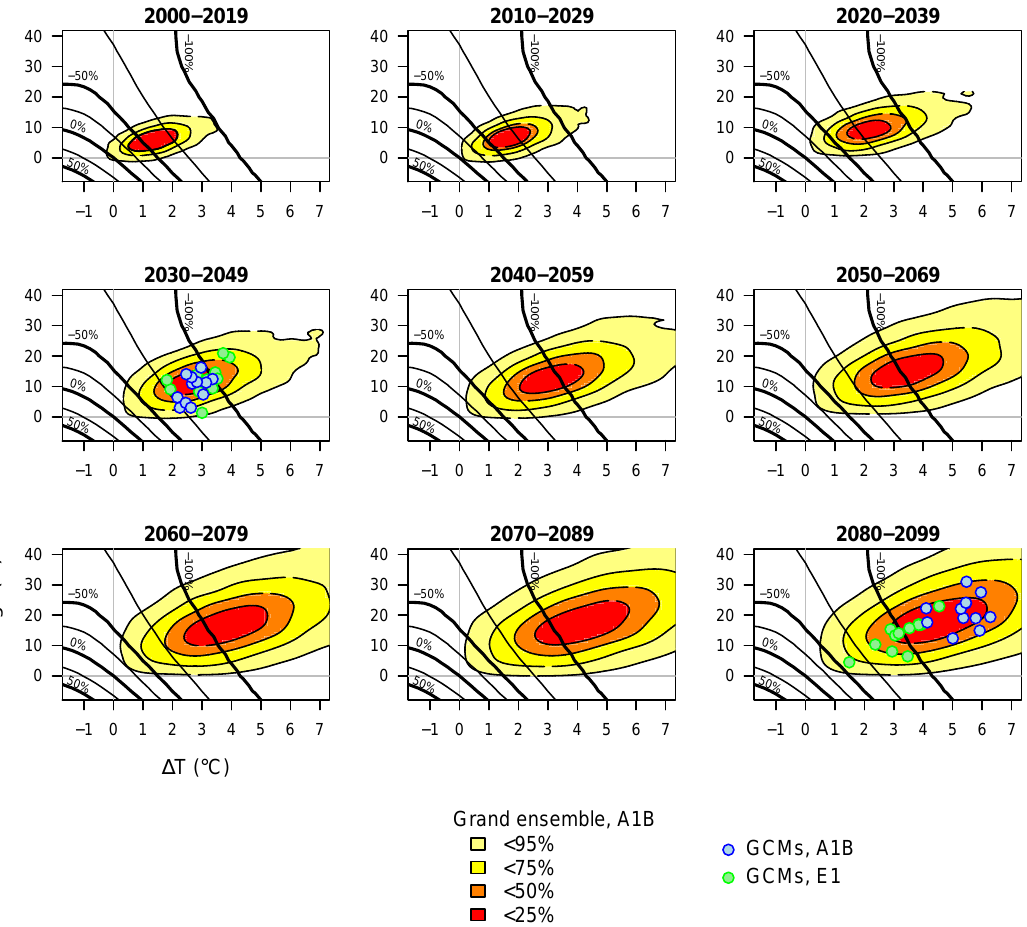
Fig. 5. Impact response surface showing the change in area suitable for palsa mires (contours in 25% steps from 50% to − 100%) and projections of changes in mean annual temperature and precipitation relative to 1961–1990 for Grand Ensemble with A1B (coloured areas; Harris et al. 2010) and a GCM ensemble with forcing from the E1 mitigation scenario and A1B for nine periods in the 21st century. The impact response surface depicts the 25-model mean using GAM and 1961–1990 calibration